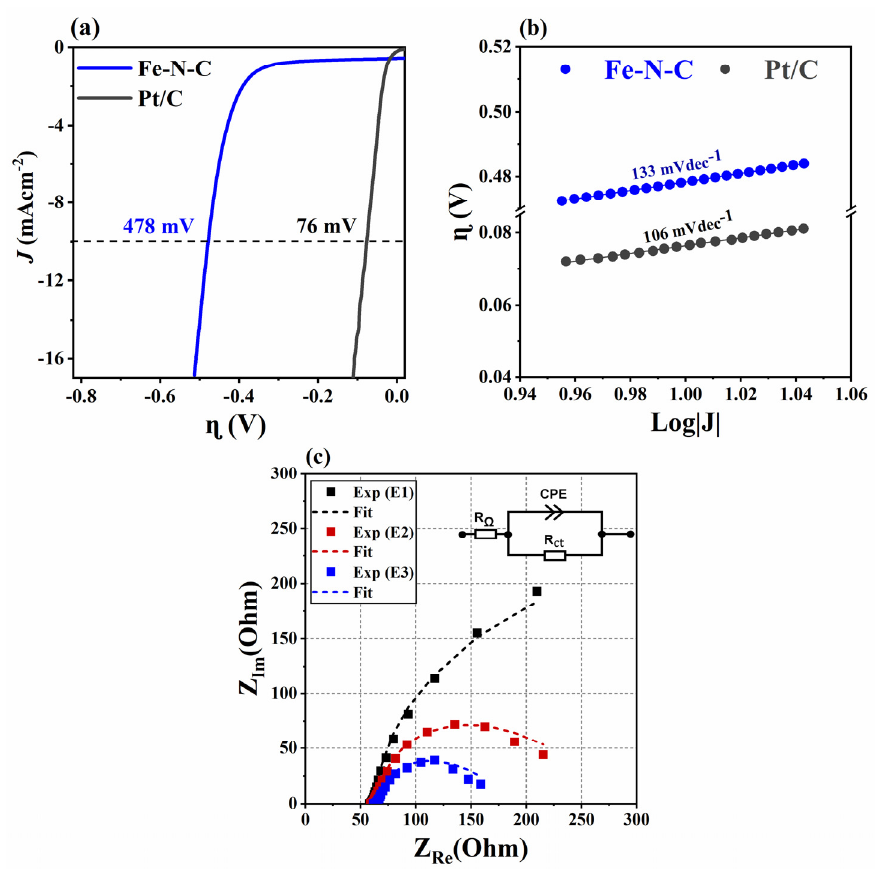
Figure 4. Electrochemical characterization for the Fe-N-C and Pt/C catalysts in N 2 -saturated 0.1 M KOH electrolyte: ( a ) LSV curves at 5 mVs − 1 ; ( b ) Tafel plot, and ( c ) Nyquist plot at different potential values and equivalent circuit (inset of Figure 4c) for data fitting (experimental data-pointed line, data fit-dashed line). Table 2. HER parameters at a current density of − 10 mAcm − 2 for the synthesized Fe-N-C material and other PGM and PGM-Free catalysts reported in literature.